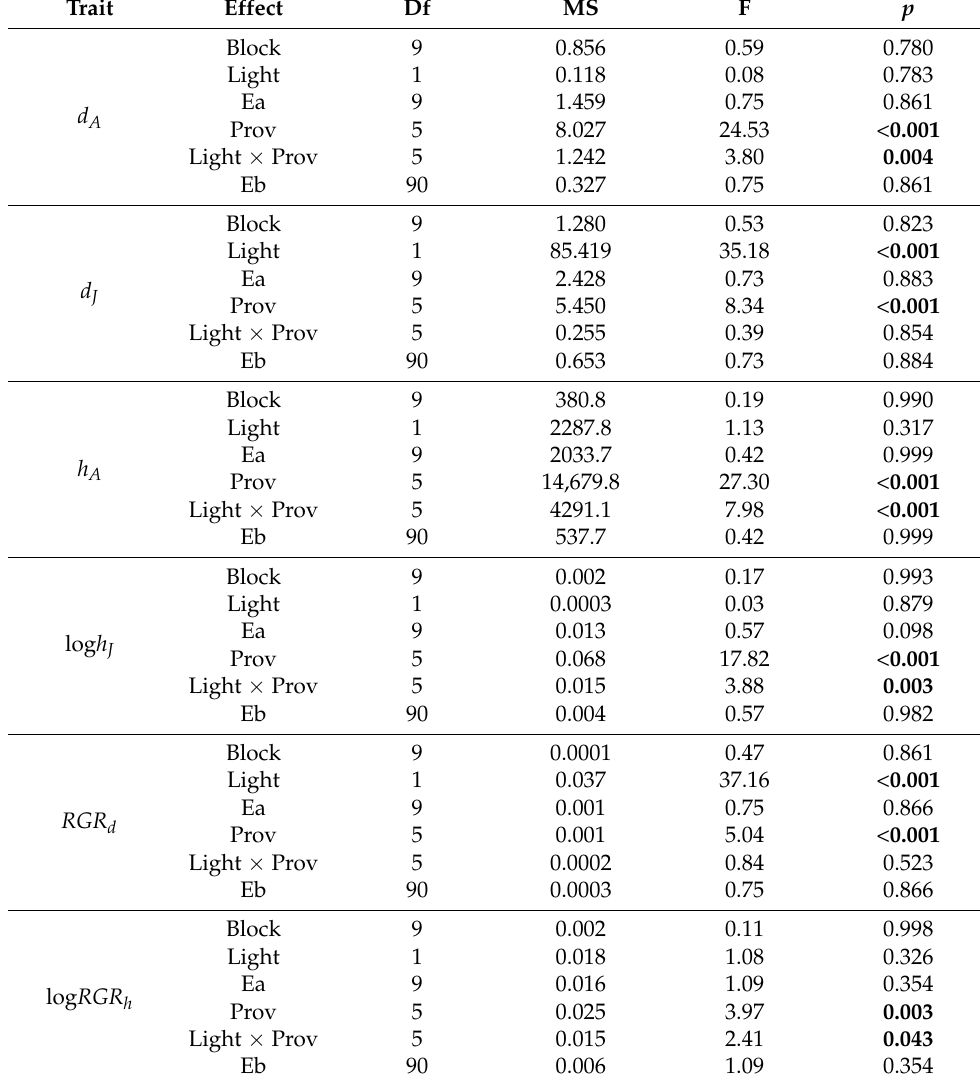
Table 3. The split-plot analysis of variance for the effects of blocks (replicates), irradiance level (40% or 100% of full solar irradiance), and provenance of Abies alba seedlings on diameter at root collar and height of seedling measured in April and June 2019 ( d A , d J , h A , h J ) and on relative growth rates of diameter ( RGR d ) and height ( RGR h ) of silver fir seedlings originating from one of six provenances (see Table 1) and acclimated to full light or shade. The values of probability in bold indicate significant differences between means ( p < 0.05). Df —degrees of freedom; MS —mean sum of squares; F —value of Snedecor’s function; p